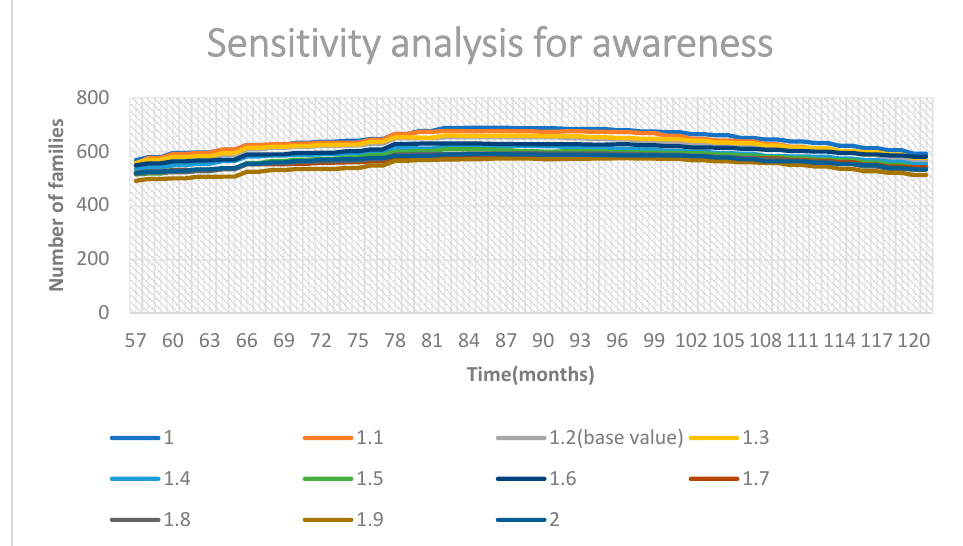
Figure 9. The effect of different weights of awareness on transformation outcomes. The result indicates that awareness has very little impact on transformative adapta- tion outcomes within the community. The simulation indicated a reduction in the number of awareness initiatives in the community over time. This lack of urgency may be respon- sible for the results seen in Figure 9.